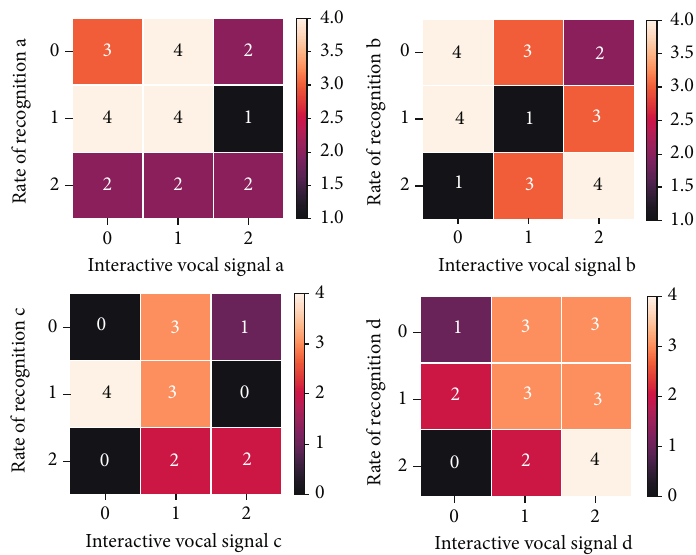
Figure 5: Prediction distribution of interactive vocal signals under emotion